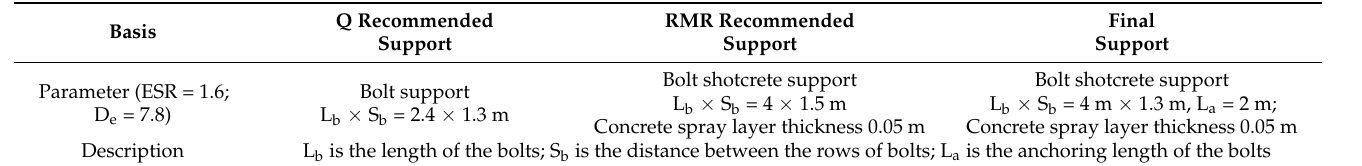
Table 6. Design of the bolting and shotcrete support bolt mesh and shotcrete layer thickness.